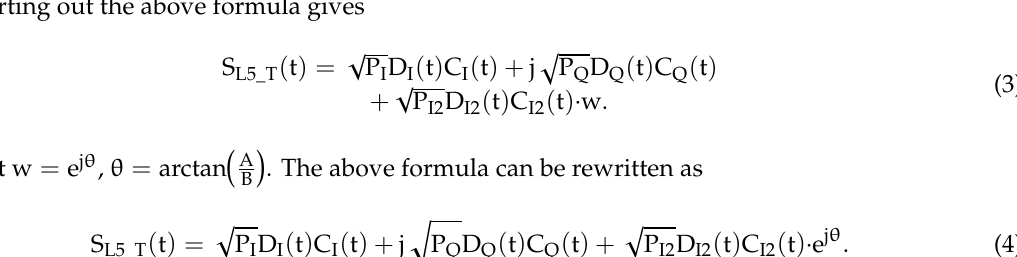
Figure 10. QZS-2 satellite L5 frequency signal constellation diagram.